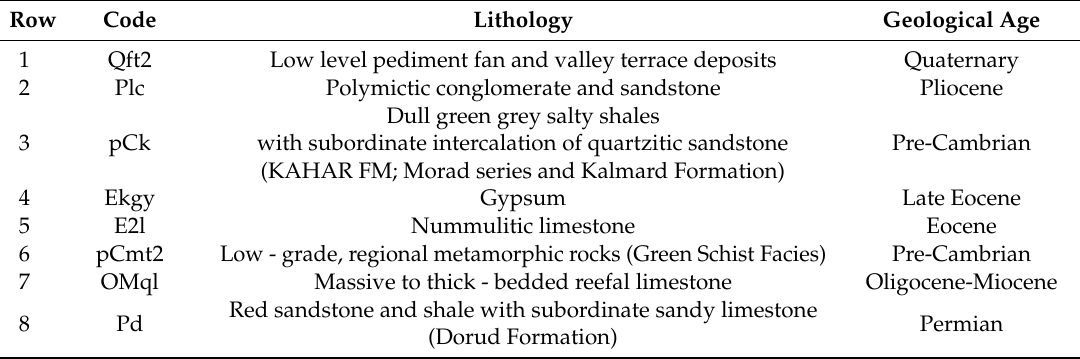
Table 1. Lithology available in Robat Turk